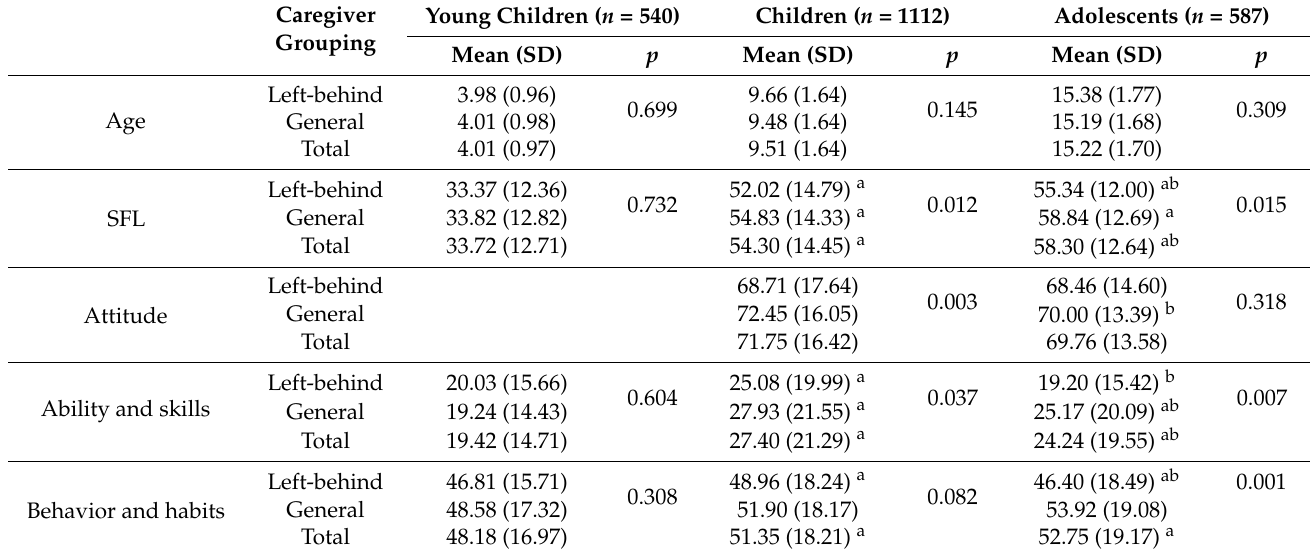
Table 3. Scientific fitness literacy and sub-dimensional scores for